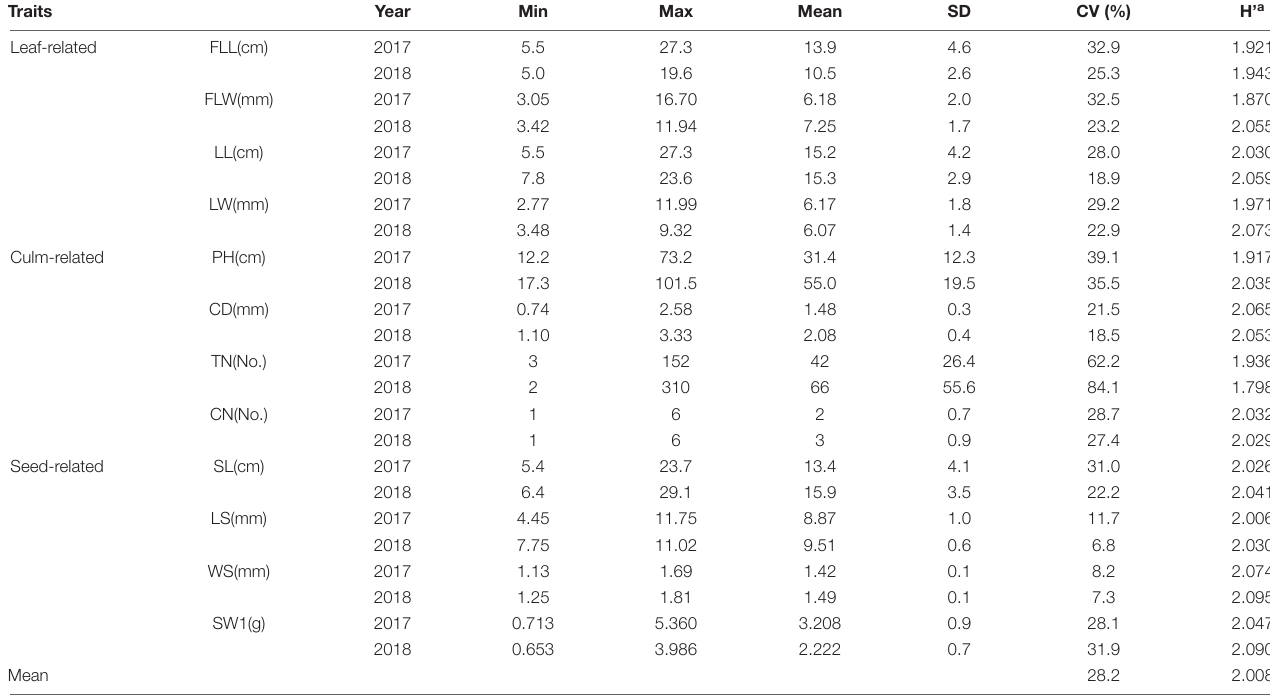
TABLE 2 | Phenotypic variation statistics of genome-wide association study (GWAS) population.